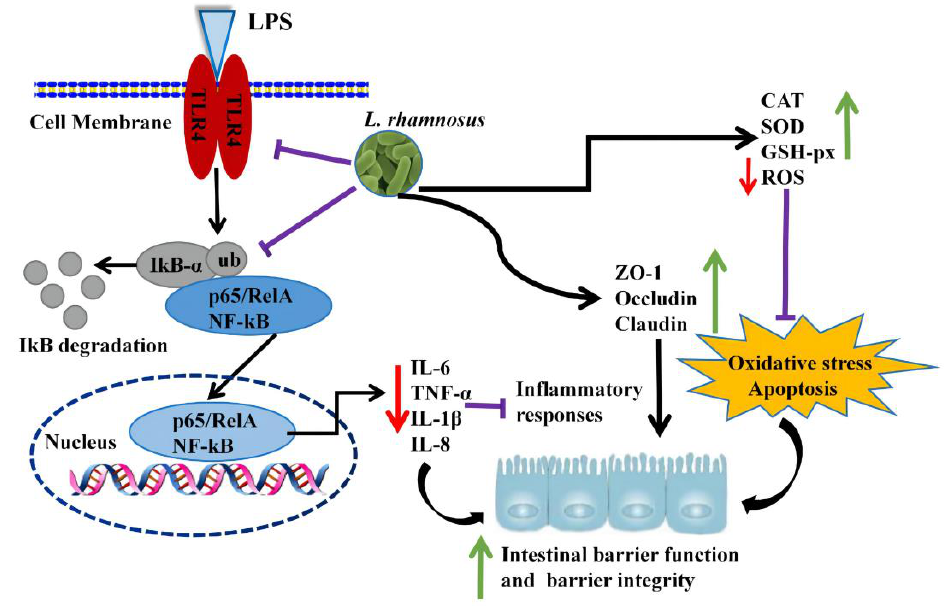
Figure 8. L. rhamnosus CY12 prevented LPS-induced intestinal barrier function damage in Caco-2 cells by increasing tight junction protein expression and decreasing oxidative stress and inflammation. Note: green ↑ : upregulation of genes or proteins expression; red ↓ : downregulation of genes or proteins expression; all black → : promote or result in; purple ⊥ : the genes or proteins expression were inhibited.